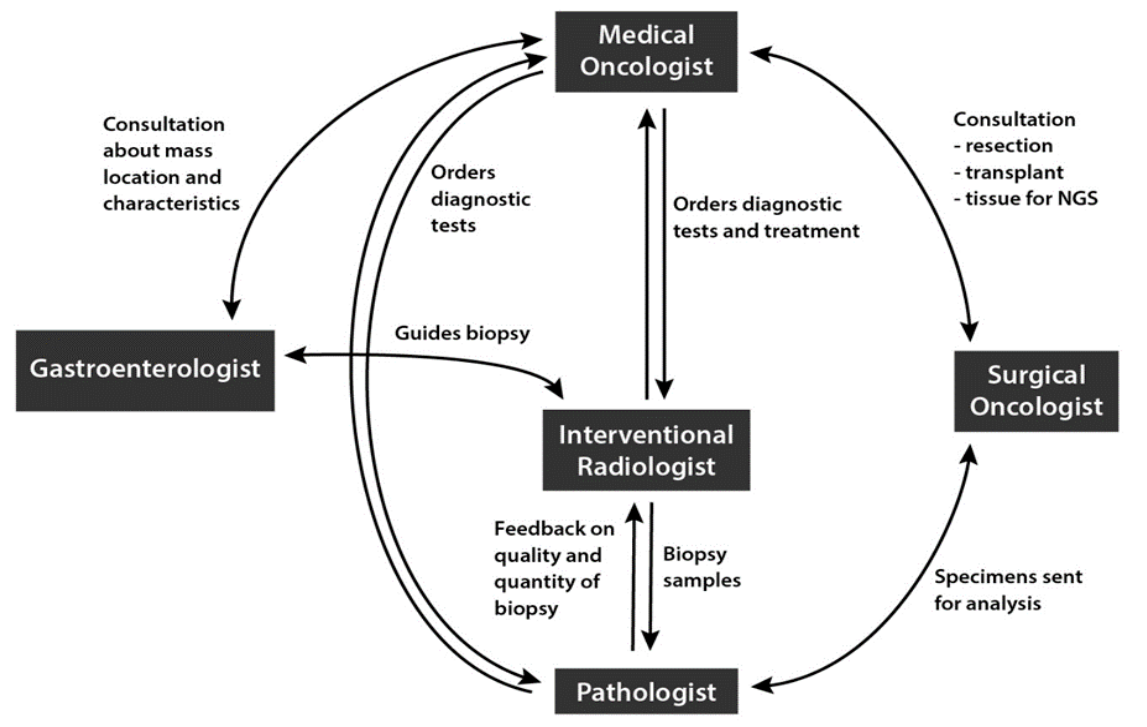
Figure 3. Communication and coordination within the multidisciplinary team in the diagnosis and treatment of iCCA.